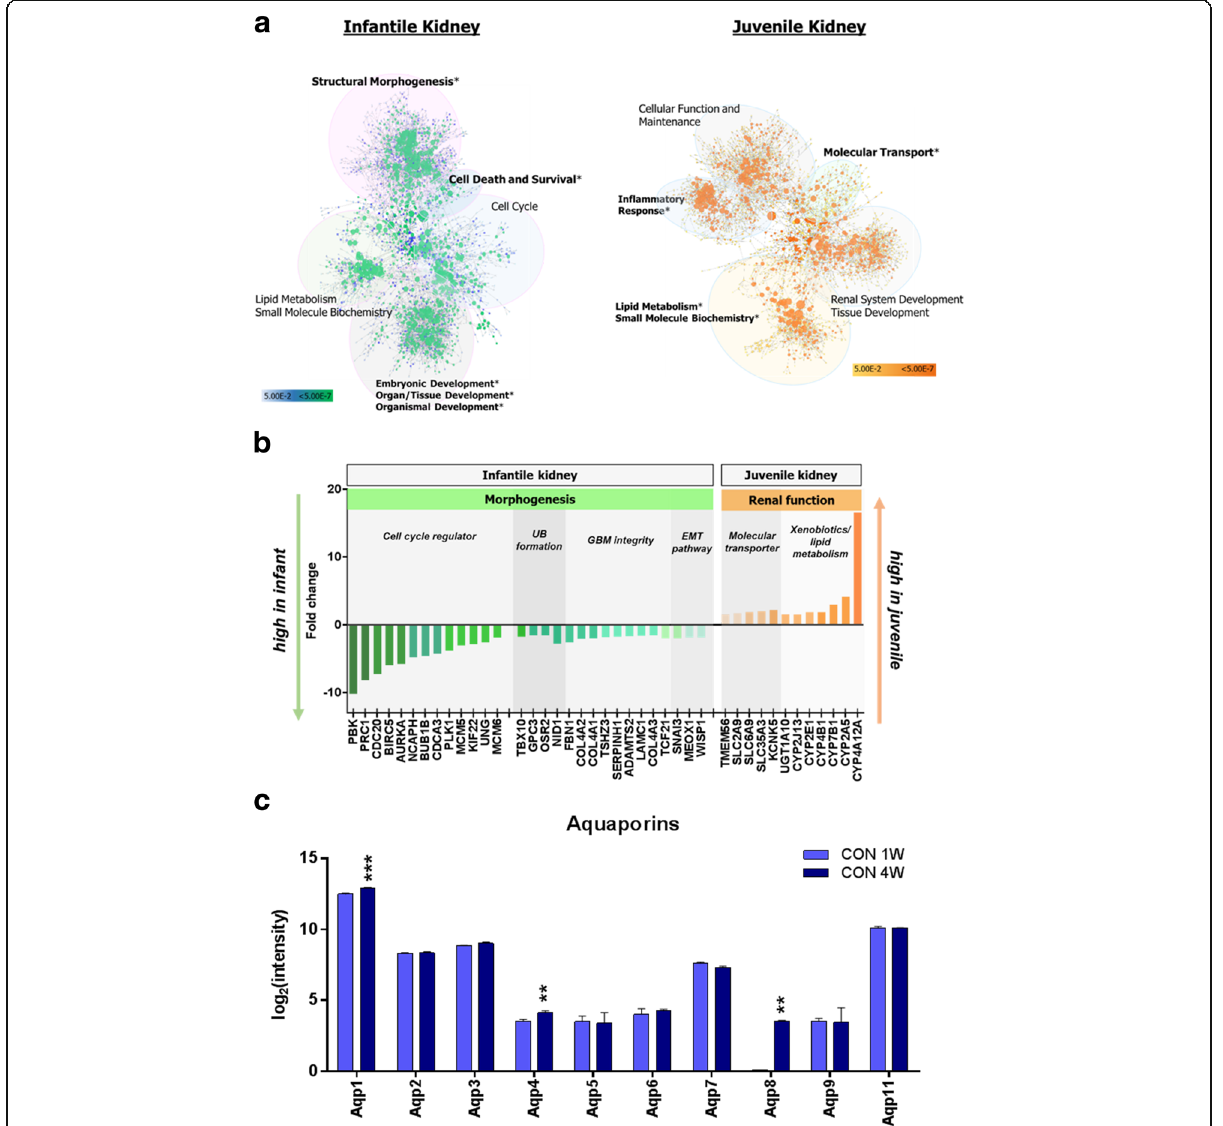
Fig. 3 Distinctive functional network of genes in normal renal development during postnatal life. a Functional network of gene sets of CON 1W (4 weeks old; infant) and CON 4W (7 weeks old; juvenile). Gene ontology (GO) was categorized based on Ingenuity Pathway Analysis (IPA) knowledge. GO terms in bold with asterisk indicate enriched biological functions in gene set enrichment analysis. Each node represents a biological function and its color and size indicate the p value and number of genes in the cluster, respectively. b Identification of significant genes related to postnatal renal development. c The increasing transcript levels of aquaporin family with age support that functional maturation were taking place in the kidneys of infant and juvenile mice. UB ureteric bud, GBM glomerular basement membrane, EMT epithelial-mesenchymal transition. Data are expressed as mean±SEM. Student ’ s t test; * p <0.05, ** p <0.01, *** p